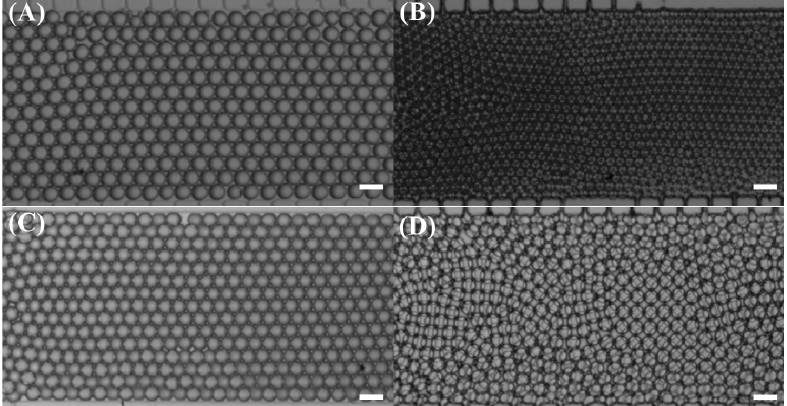
Figure 4. Optical microscopic images of the microdroplets assembly configurations at various flow rates and at different microfluidic devices with ( A ) and ( C ) in close-packed single-layer mode, ( B ) and ( D ) in close-packed double-layer mode. In ( A ) and ( B ), the microdroplets were generated in the same microfluidic device with w f = 25 μ m; in ( C ) and ( D ), the microdroplets were formed in the same microfluidic device with w f = 50 μ m. In ( A ) and ( C ), the microdroplets were generated in dripping region; in ( B ) and ( D ), the microdroplets were formed under jetting mode. Q o and Q w were 90 and 20 μ L·h − 1 ( A ), 600 and 60 μ L·h − 1 ( B ), 800 and 100 μ L·h − 1 ( C ), 2000 and 400 μ L·h − 1 ( D ). The oil phase and water phase were all hexadecane with 2.7% ( w/v ) Span80 and DI water. Scale bars are 50 μ m.